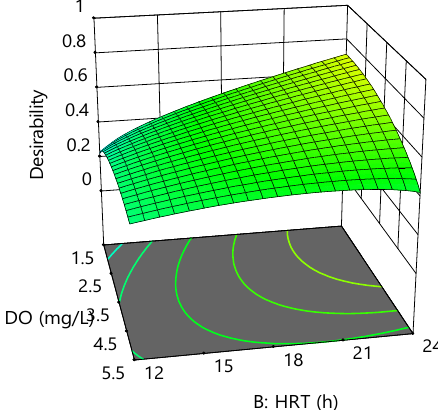
Figure 7. Desirability fitted 3D surface at an SRT of 5 days.